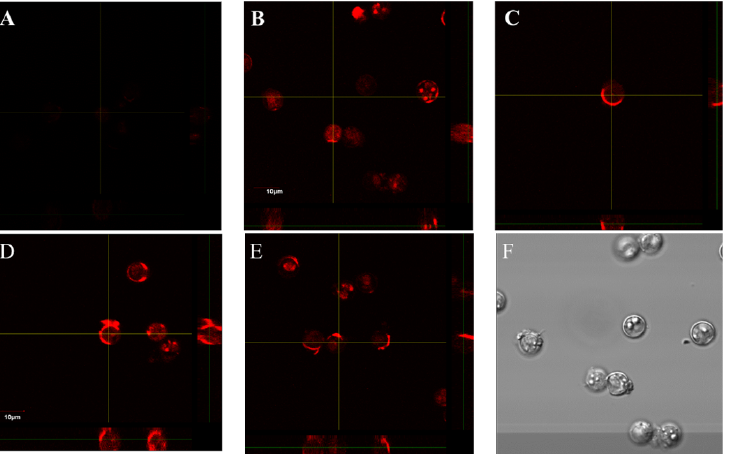
Figure 1. Confocal fluorescence microscopy of Cyclospora cayetanensis oocysts after aptamer-based staining. Oocysts were stained with the top 8 DNA aptamer sequences containing 5’-biotin linkers at ~150 µg/mL in phosphate-buffered saline (PBS) for 30 min at room temperature and then washed by centrifugation at 13,000× g , and then the pelleted oocysts were resuspended in streptavidin– Texas Red conjugate for 15 min and washed again prior to confocal microscopy. Note that both the oocyst cell surface and interior structures (developing or developed spores) stained with each of the aptamers in panels ( B – E ) but not with a scrambled sequence DNA aptamer control shown in panel ( A ). Panel ( F ) shows the appearance of the unstained 8–10 µm oocysts under phase contrast microscopy. Total magnification = 400×.